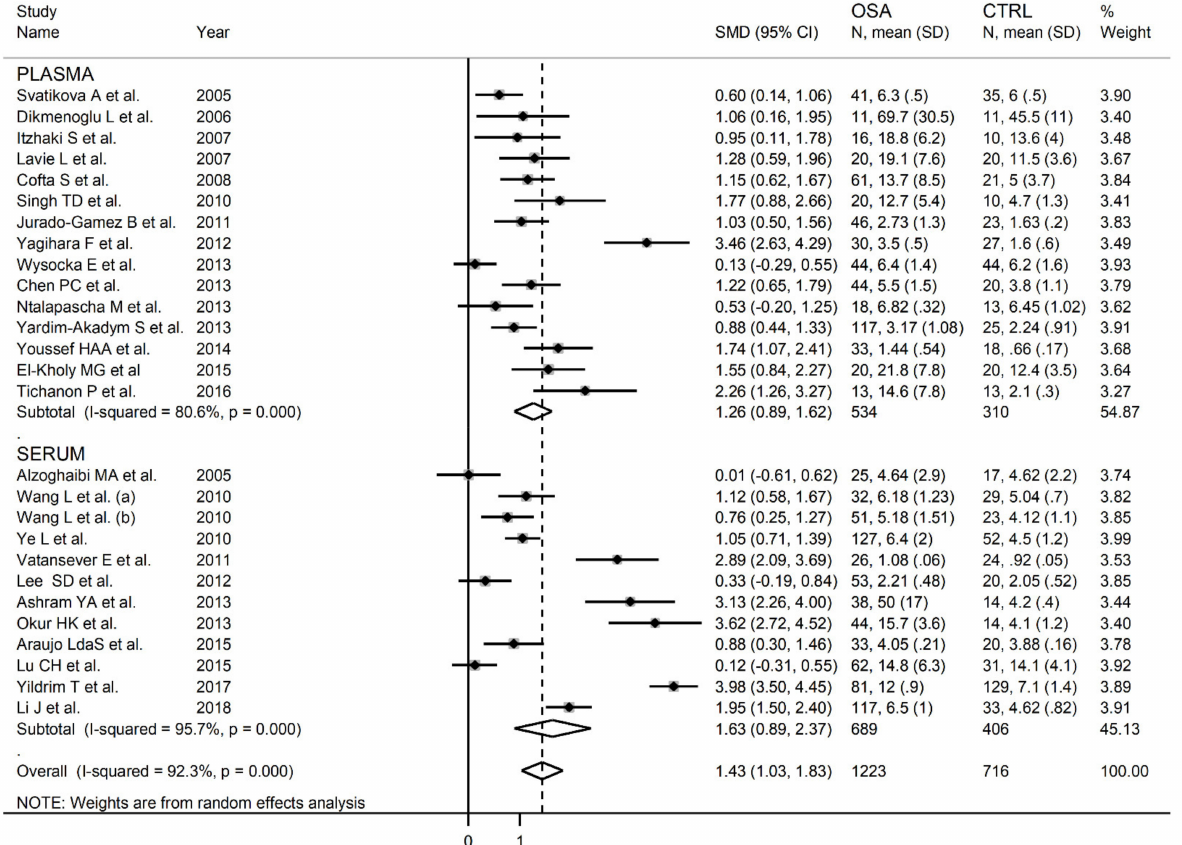
Figure 6. Forest plot of studies examining MDA concentrations in OSA and in controls according to the type of biological sample (plasma or